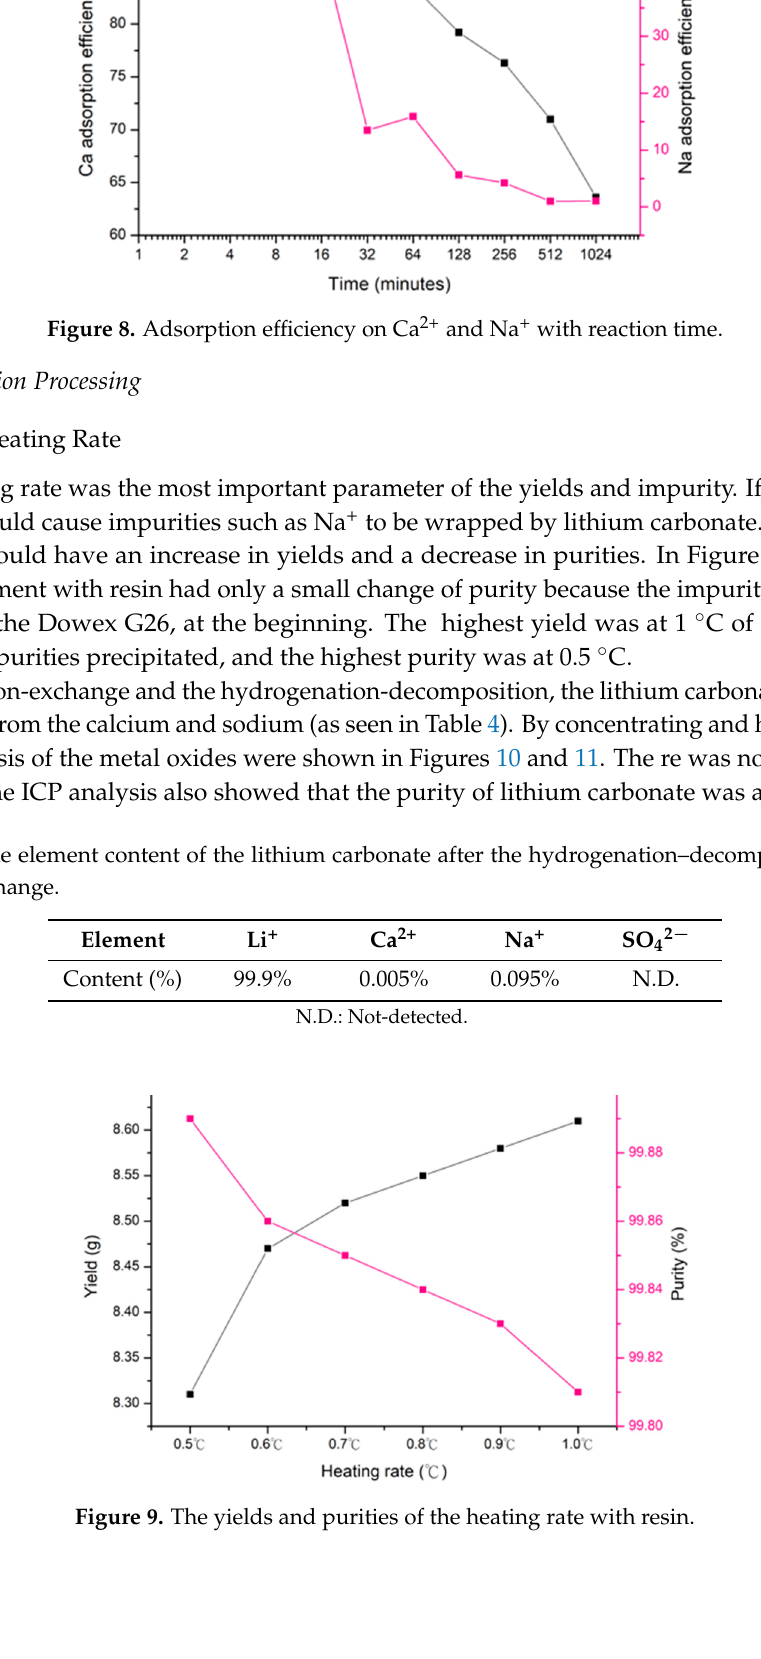
Figure 8. Adsorption efficiency on Ca 2+ and Na + with reaction time. Table 3. The composition of lithium bicarbonate solutions.